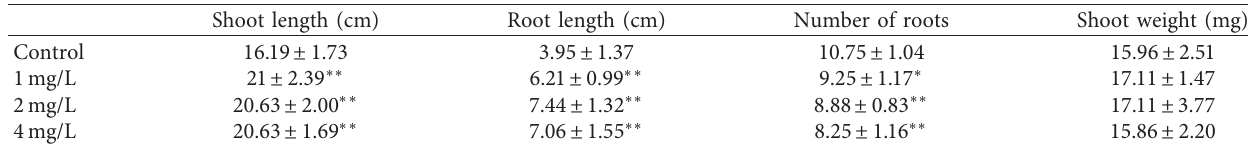
Table 2: Shoot length, root length, number of seminal roots, and shoot weight in H. vulgare L. seedlings grown 14 days with 0, 1, 2, and 4 mg/ L of ZnO NPs.